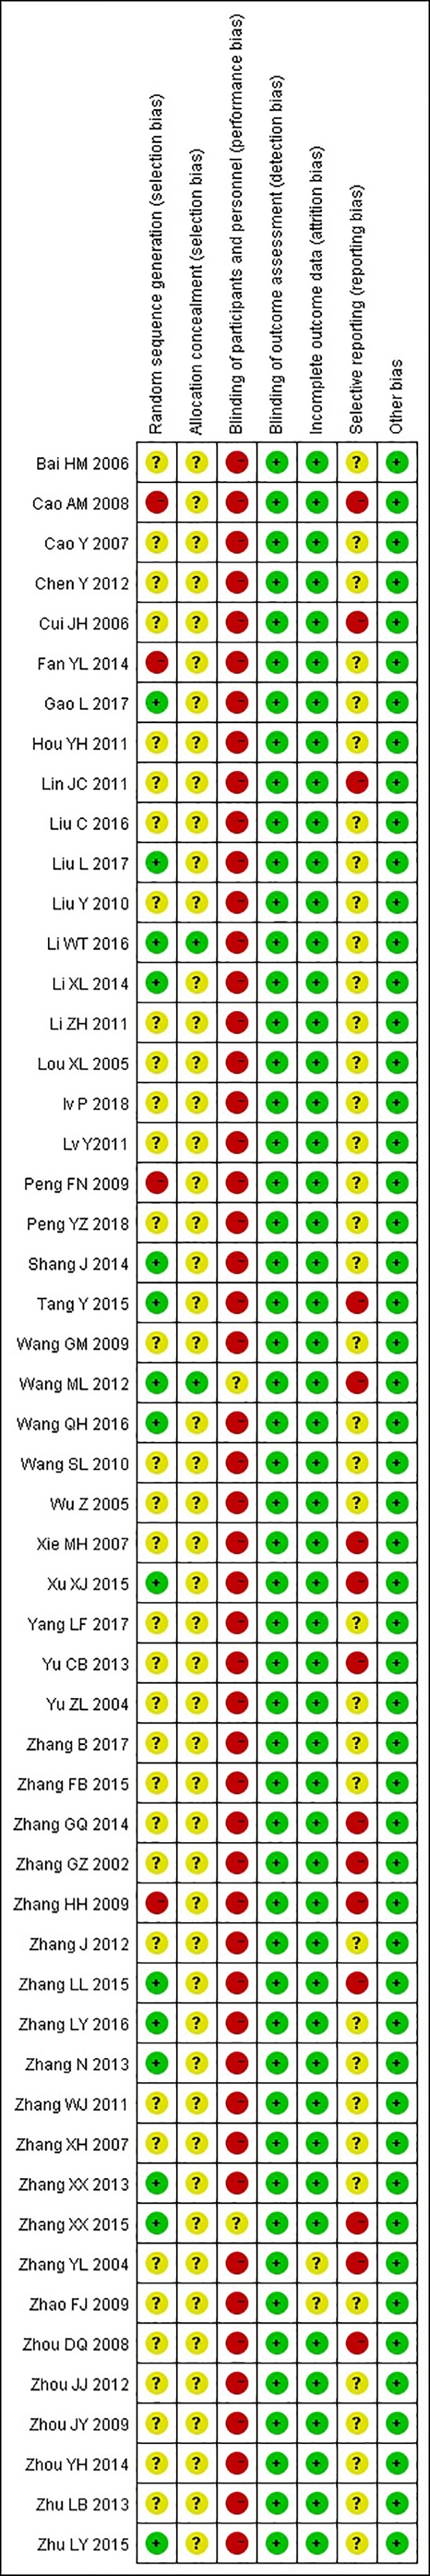
Risk of bias summy of included studies.